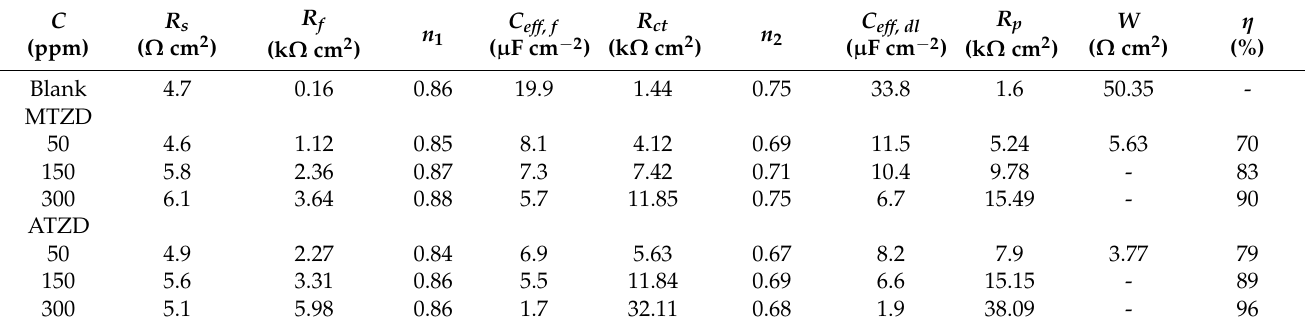
Table 1. EIS parameters for copper in 3.5 wt.% NaCl solution and in presence of thiazolidinedione derivatives at 298